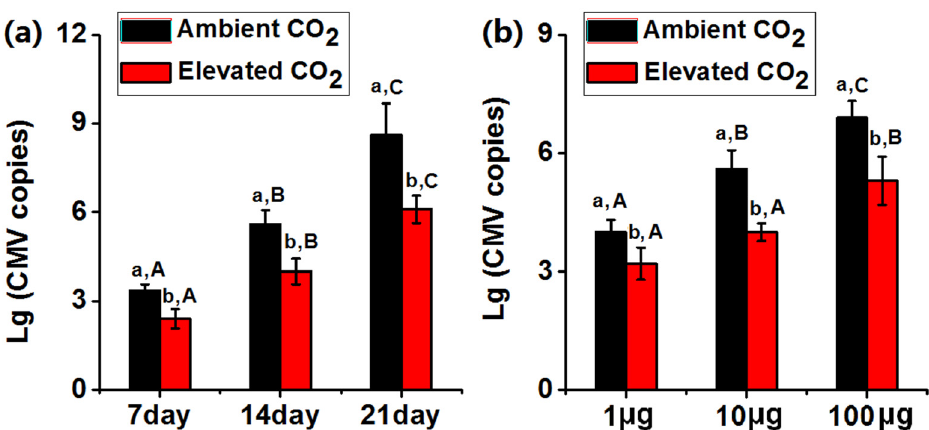
Figure 1. Elevated CO 2 decreased CMV copy numbers in Nicotiana tabacum . ( a ) Accumulation of RNA 3 of CMV in N. tabacum post mechanical inoculation with the virus for 7 days, 14 days and 21 days under ambient CO 2 and elevated CO 2 . ( b ) Accumulation of RNA 3 of CMV in N. tabacum post mechanical inoculation with 1, 10 and 100 µ g virus for 14 days under ambient CO 2 and elevated CO 2 . Data represent means ± SE (Tukey’s multiple range test, p < 0.05). Different lowercase letters indicate significant differences between ambient CO 2 and elevated CO 2 within the same time point or virus concentration. Different uppercase letters indicate significant differences among time points or virus concentrations within the same CO 2 treatment ( p < 0.05). Error bars indicate standard errors. Lg: log to base 10.